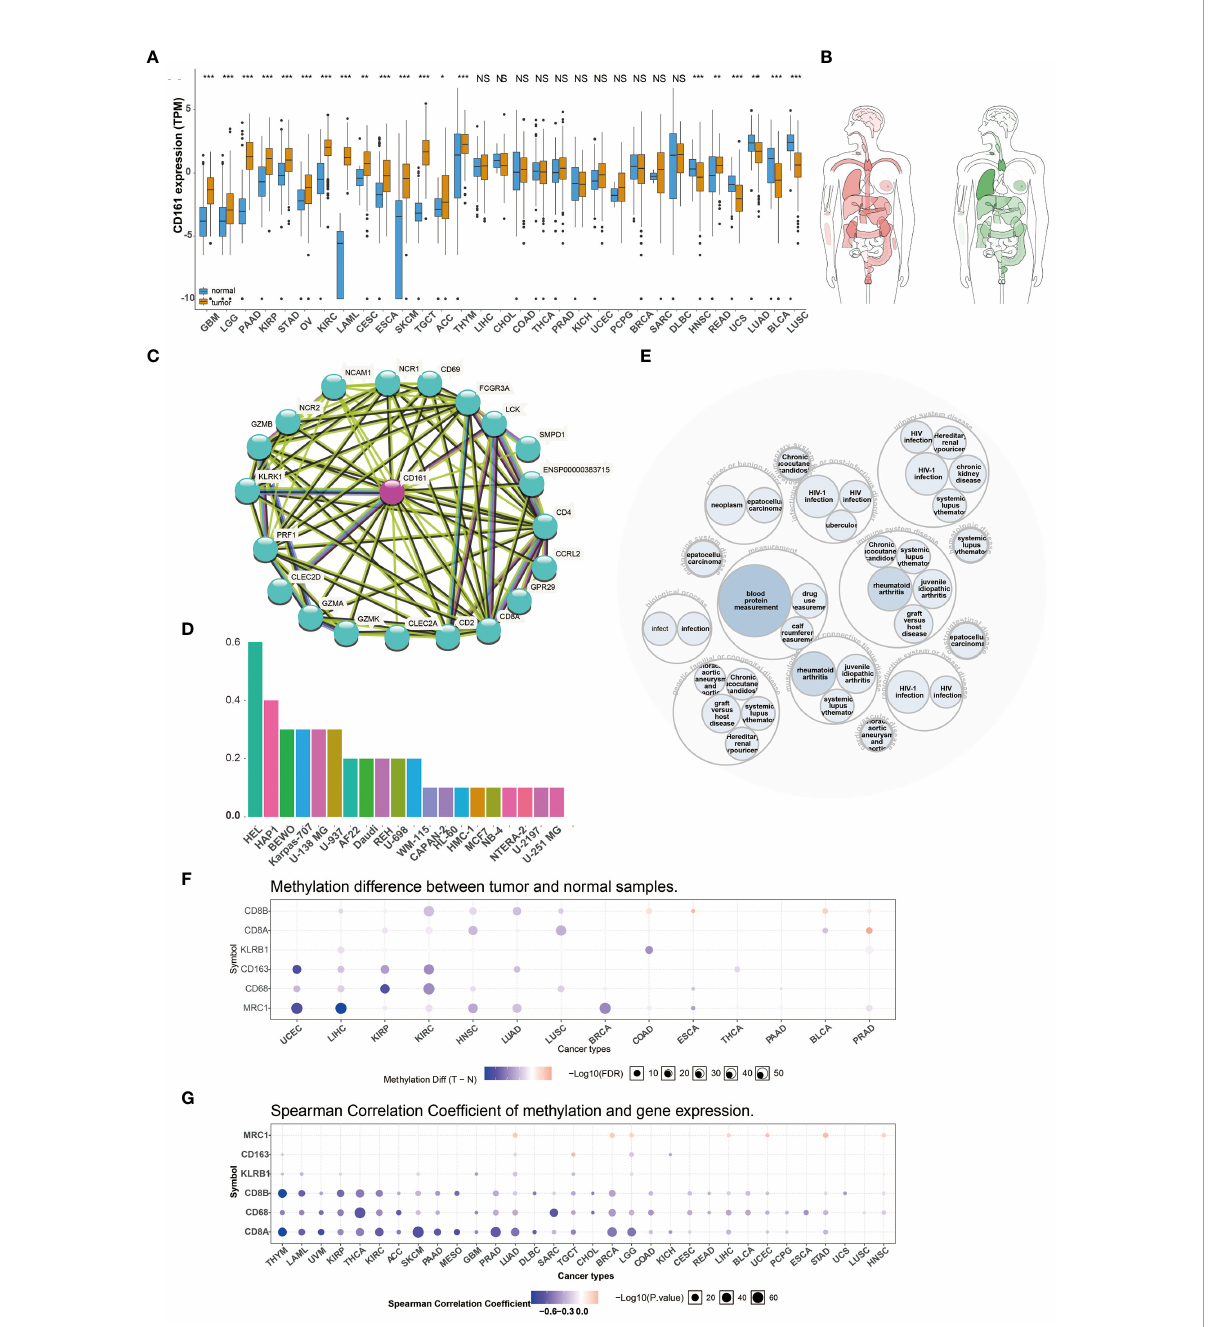
FIGURE 1 Pan-cancer Expression and Methylation Analysis of CD161. The expression of CD161 in various human cancers from TCGA dataset (A) . Median expression of CD161 in tissue samples in bodymap(red: tumor; green: regular) (B) . The protein protein interaction network related to CD161 (C) . The expression of CD161 in different cell lines (D) . A disease network interaction analysis of CD161 (E) . Tumor and normal tissues show differential methylation of KLRB1 and marker genes of T cells and macrophages in 14 cancer types (F) . Bubble map showing the correlation between the expression of KLRB1 and marker genes of T cells and macrophages and methylation across different cancer types (G) . ns, not statistically signi fi cant; *P < 0.05; **P < 0.01; ***P <